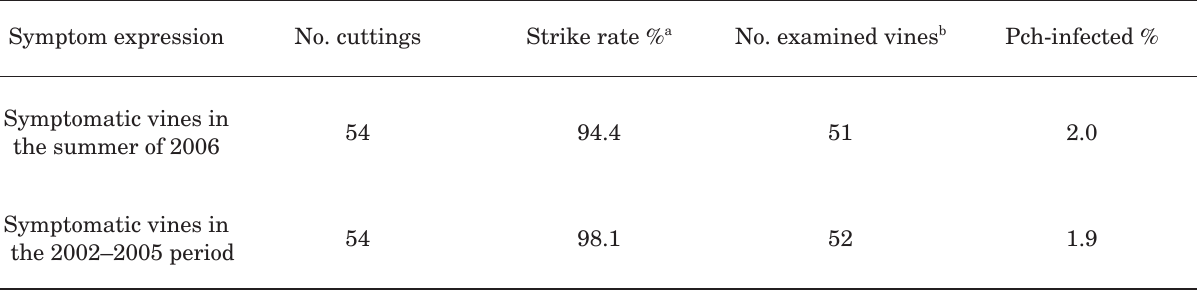
Table 7. Strike rate and P. chlamydospora (Pch) infection of Sauvignon blanc cuttings collected from esca symptomatic vines in 2007.